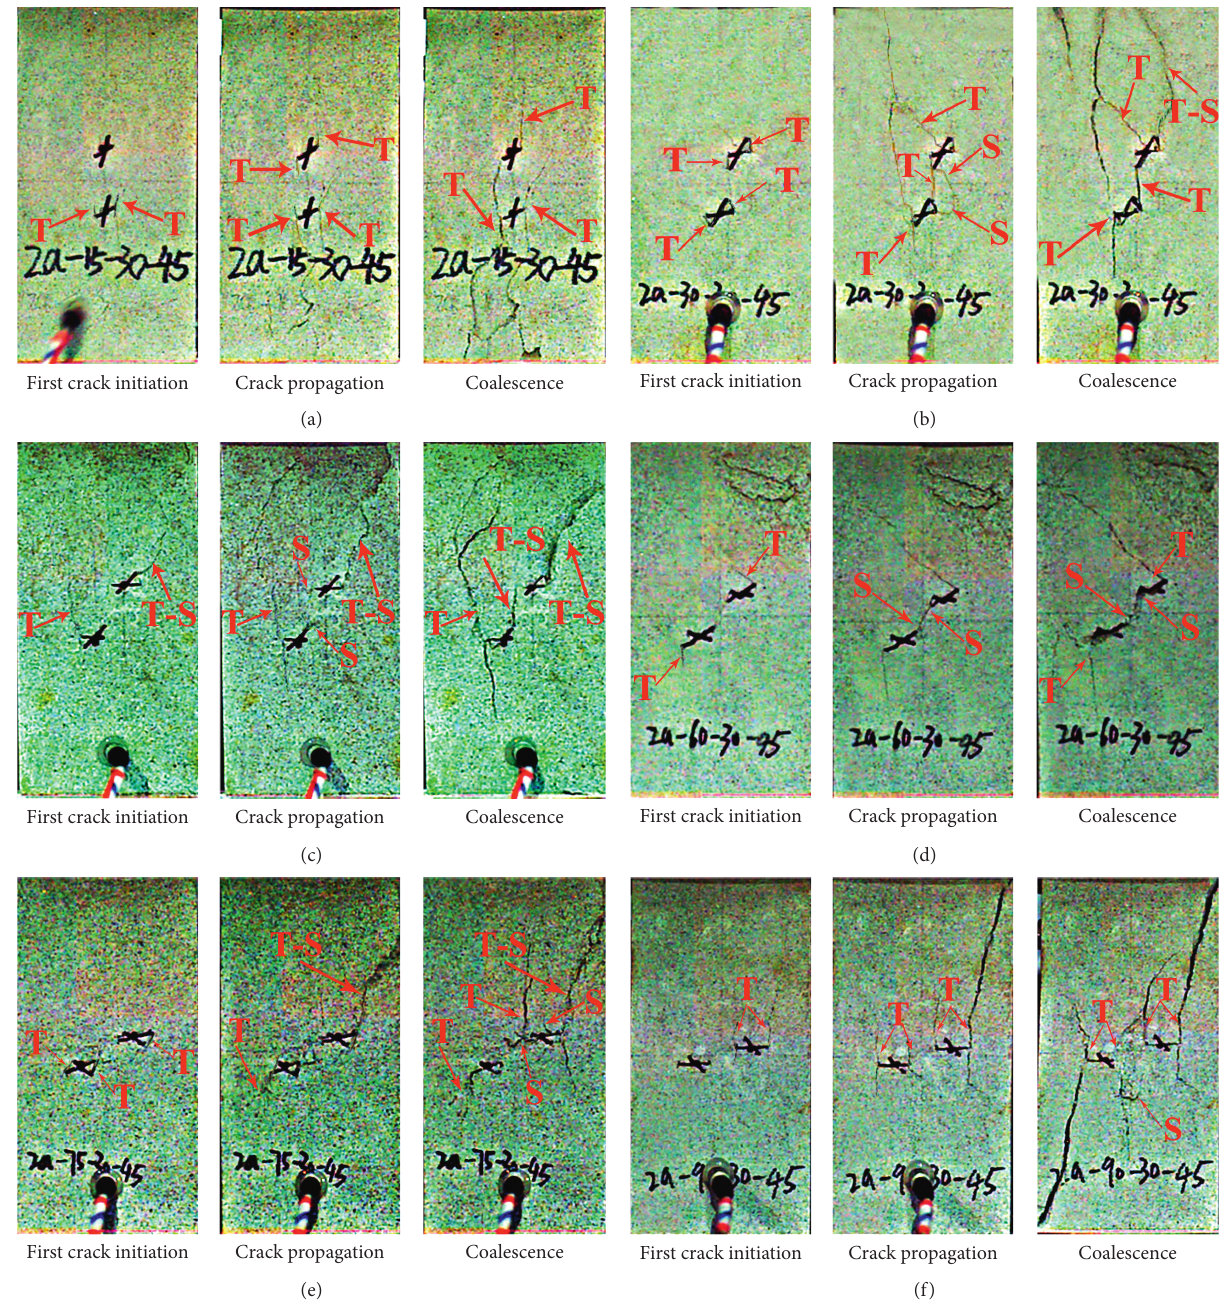
Figure 7: Crack evolution diagram of α : (a) α � 15 ° , (b) α � 30 ° , (c) α � 45 ° , (d) α � 60 ° , (e) α � 75 ° , and (f) α � 90 °